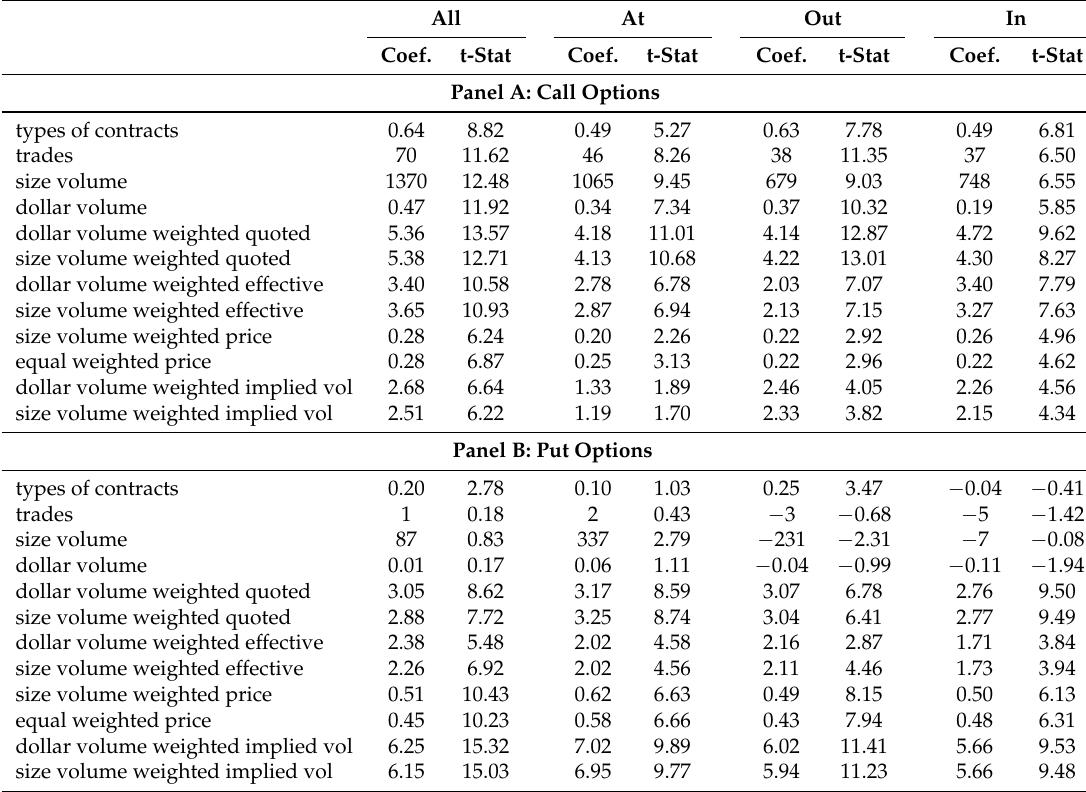
Table 6. Two way fixed effect specification